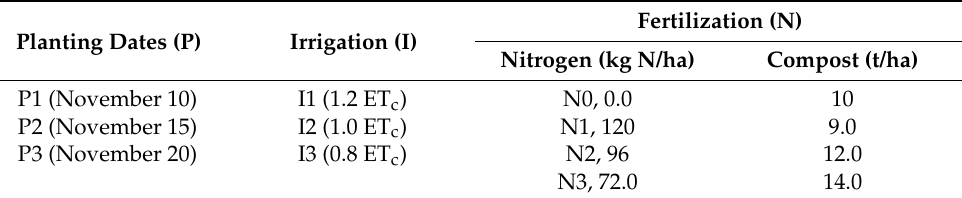
Table 1. The studied treatments of planting dates, irrigation, and fertilization for spring wheat over two growing seasons. Fertilization (N) Planting Dates (P) Irrigation (I) Nitrogen (kg N/ha) Compost (t/ha) P1 (November 10) I1 (1.2 ET c ) N0, 0.0 P2 (November 15) I2 (1.0 ET c ) N1, 120 9.0 P3 (November 20) I3 (0.8 ET c ) N2, 96 12.0 N3, 72.0